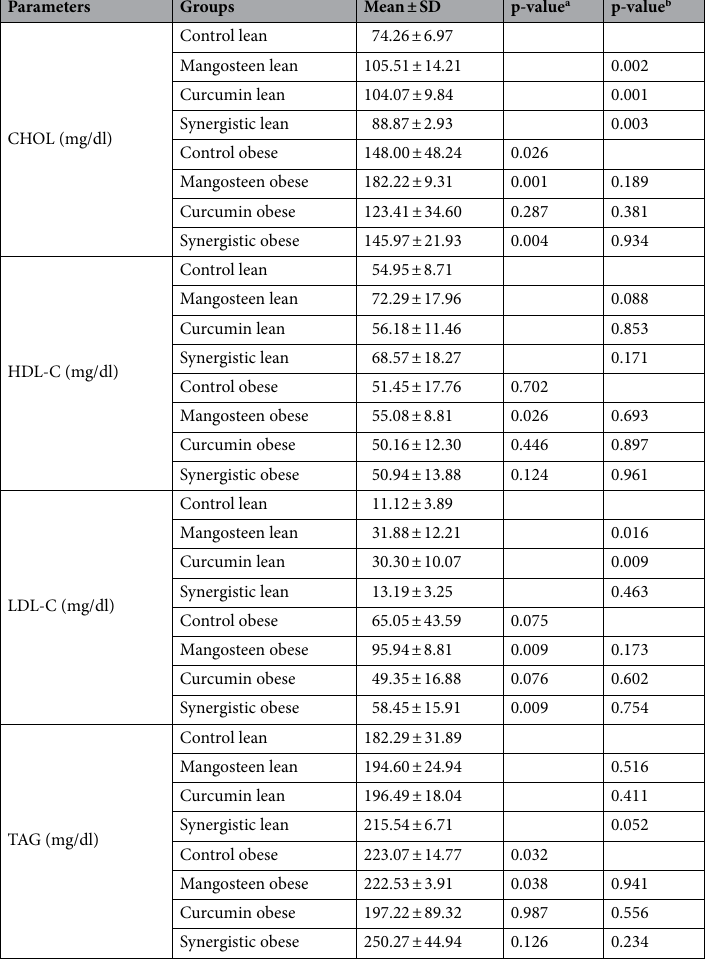
Table 3. Independent and synergistic effects of curcumin and mangosteen extract on the lipid profiles of lean and HFD-induced obese rats. a Significant difference between normal weight and obese rats in each group (control, mangosteen, curcumin, and synergistic). b Significant difference between each group and respective normal weight or obese control